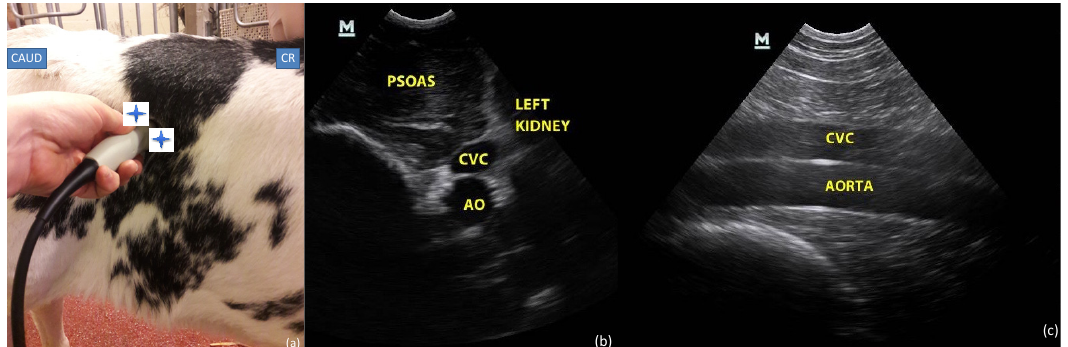
Figure 2. Paralumbar site: ( a ) probe placement site and ( b ) transversal and ( c ) longitudinal ultrasonographic views of caudal vena cava (CVC) and aorta (Ao). The blue star shows the position of the probe marker in transversal and longitudinal view. CR: cranial; CAUD: caudal.